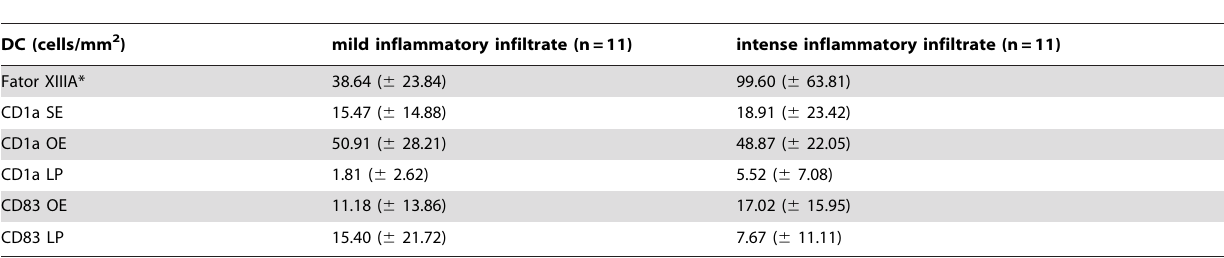
Table 2. Densities of dendritic cells (DCs) in gingival samples of individuals presenting mild and intense inflammatory infiltrate.